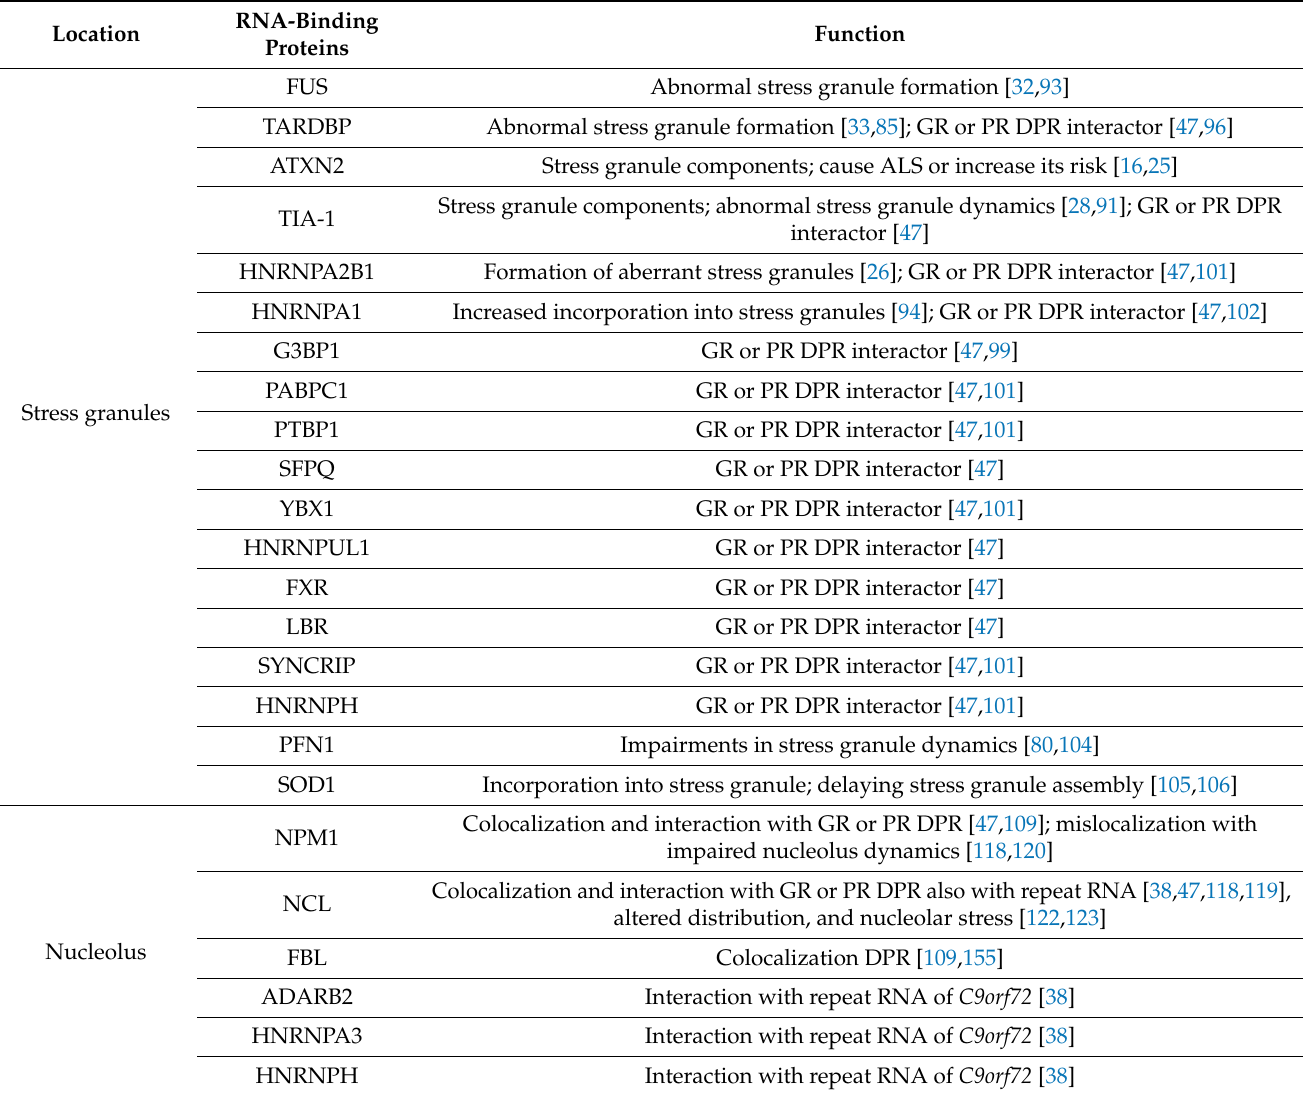
Table 1. Membrane-less organelles and the corresponding RNA-binding